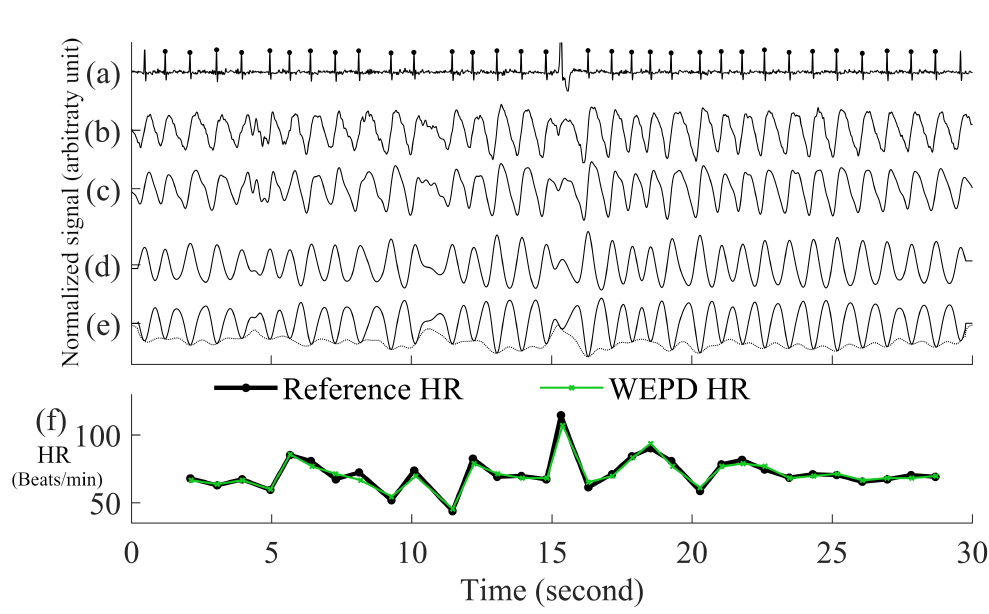
Figure 3. Step by step procedures for the proposed WEPD algorithm on a basal heart rate AF signal. The top panel ( a ) is the raw ECG signal with the reference ECG beats; panel ( b ) is a raw PPG signal, panel ( c ) is the output of the bandpass filter; panel ( d ) is the output after moving average filtering and the first derivative operation; panel ( e ) is the output after signal standardization, inversion of the signal, and application of the envelope method for local minima detection. The bottom panel ( f ) is a comparison of the heart rate (unit: beats per minute, BPM) from the reference ECG signal vs. estimated heart rate from